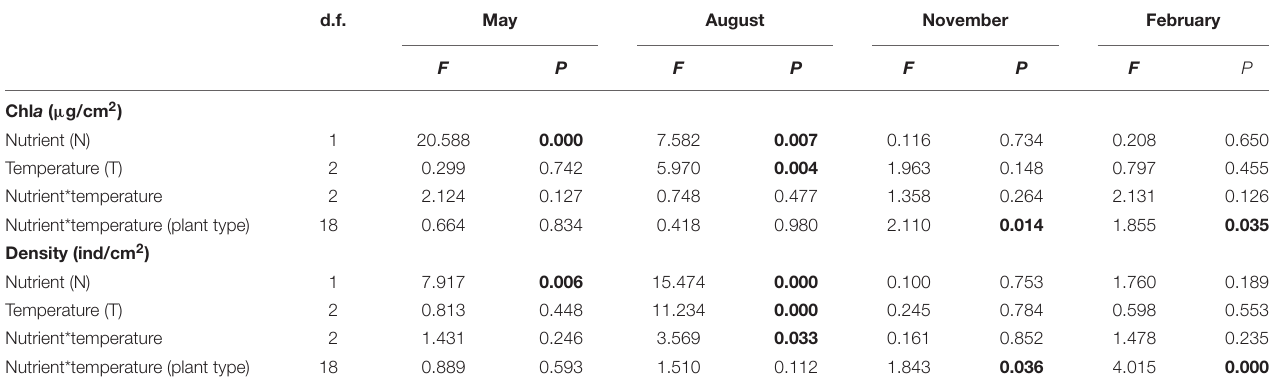
FIGURE 2 | Periphyton Chl a on four types of plant substrate in each of six treatments divided into four sampling periods representing the four seasons. Plant substrates: natural P. crispus (N-PC), artificial P. crispus (A-PC), natural E. canadensis (N-EC) and artificial E. canadensis (A-EC); treatments: ambient temperature and without nutrient addition (CON), warming and without nutrient addition (W), enhanced warming and without nutrient addition (EW), ambient temperature and nutrient addition (NP), warming and nutrient addition (W&NP), enhanced warming and nutrient addition (EW&NP); sampling periods: May, August, November, and February (representing spring, summer, autumn, and winter). TABLE 1 | Results of three-way ANOVA comparing the effects of nutrient (two levels: low and high), temperature (three levels: ambient, warming, and enhanced warming), nutrient*temperature and plant type (four levels: natural P. crispus , artificial P. crispus , natural E. canadensis , and artificial E. canadensis ) on chlorophyll a (Chl a ) and density of